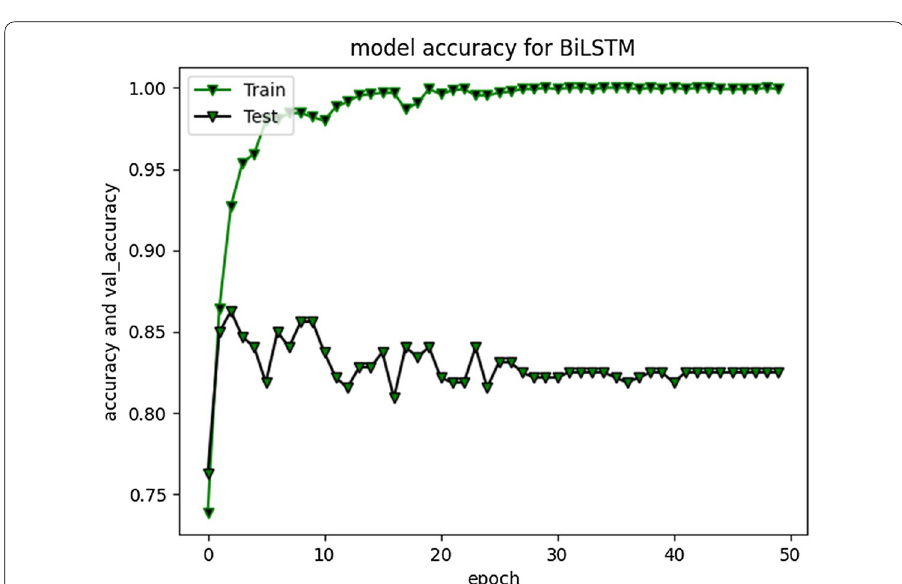
Fig. 11 RNN-biLSTM Model accuracy plot for 50